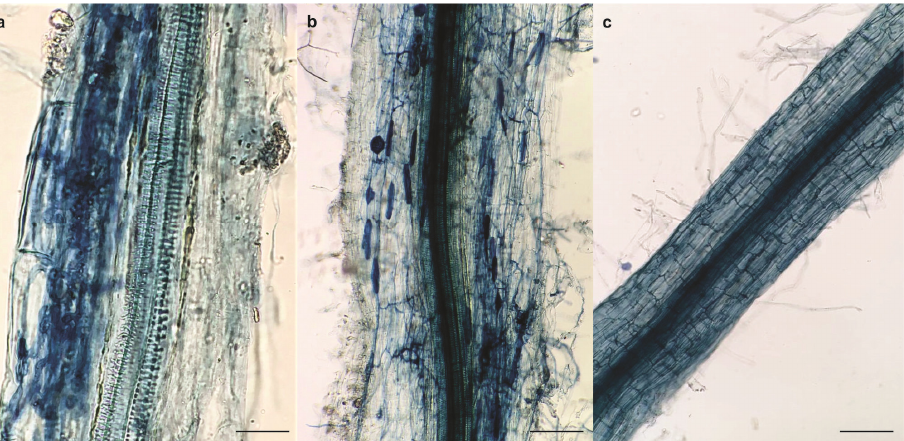
Figure 3. ( a ) Sunflower root fragments colonized by the arbuscular mycorrhizal fungus Rhizophagus intraradices GA5 strain after 6 months of growth in contaminated mine soil + volcanic ash + Zn (CSM+), and ( b ) in blank substrate (BM+); and ( c ) uncolonized root fragment of sunflower plant without inoculation of AM fungi and grown blank substrate (BM ‐ ). Bars: ( a ) 100 μ m; ( b ) 200 μ m; ( c ) 400 μ m.